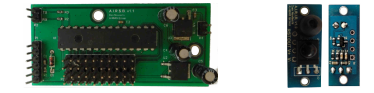
Figure 5. Range and local communication acquisition board – left; IR sensor front and back side – right.